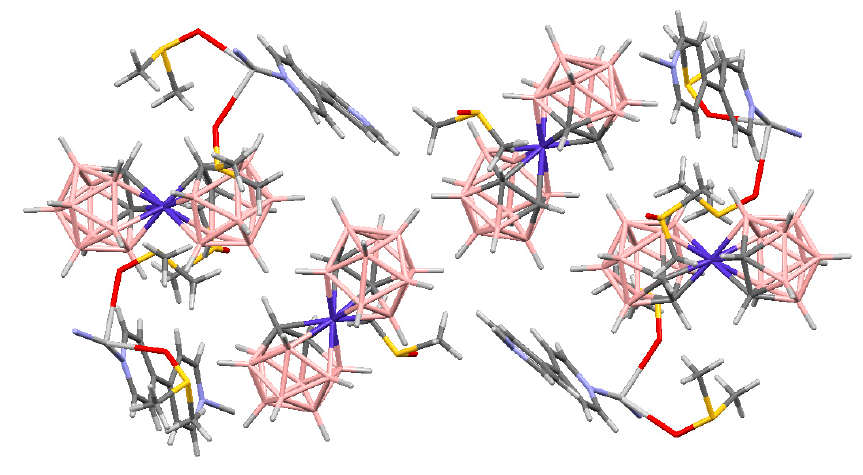
Figure 110. Fragment of the X-ray structure of {(Ag(4,4’-Bipy)(DMSO) 2 ) [3,3’-Co(1,2-C 2 B 9 H 11 ) 2 ]·DMSO} n.